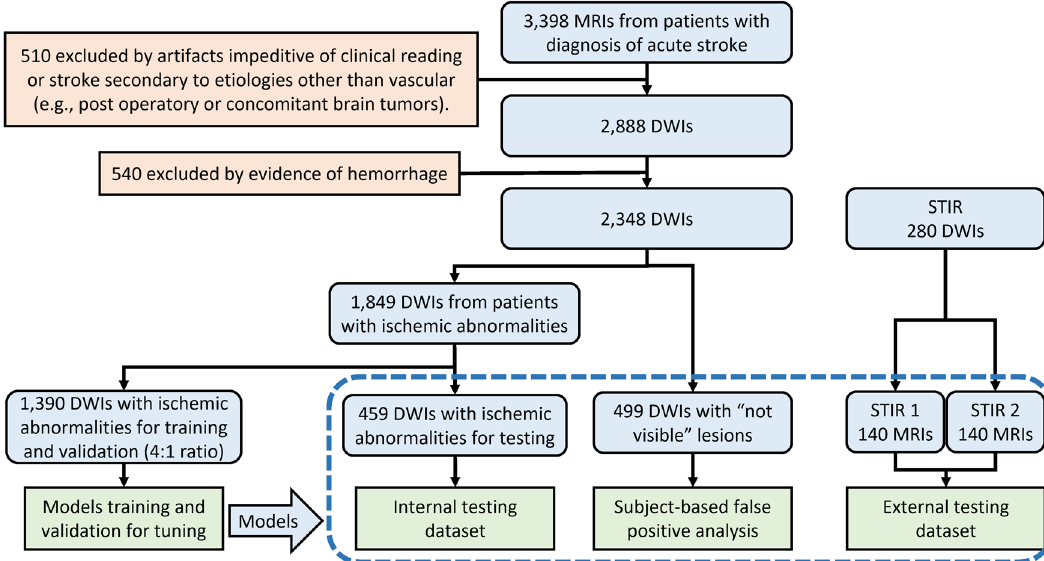
Fig. 1 Flowchart of data and analysis. The traced box shows the independent testing